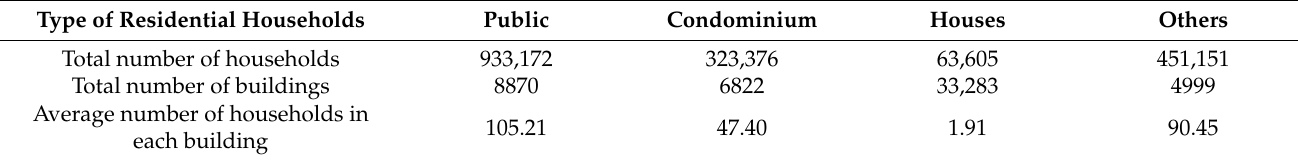
Table 1. Characteristics of different types of residential